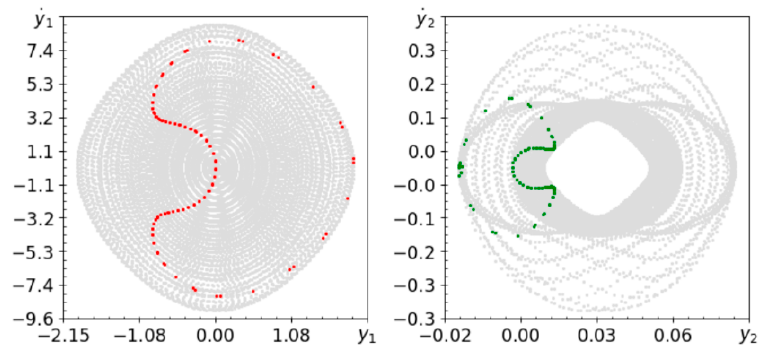
Figure 3. Phase planes (gray lines) and Poincar é maps (red and green dots) for ω = 4.94 .